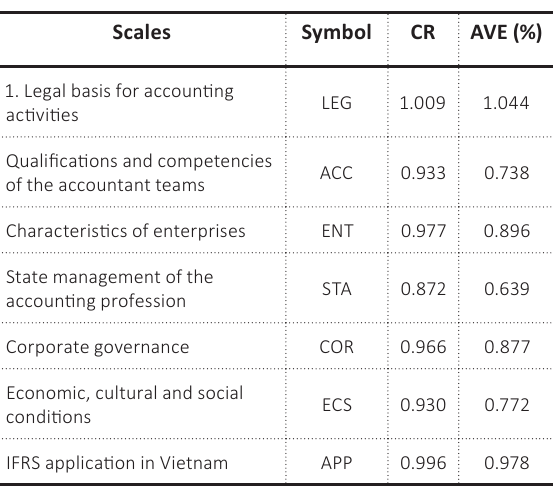
Table 3. EFA test results of scales Table 4. Results of assessing the reliability and convergence of scales